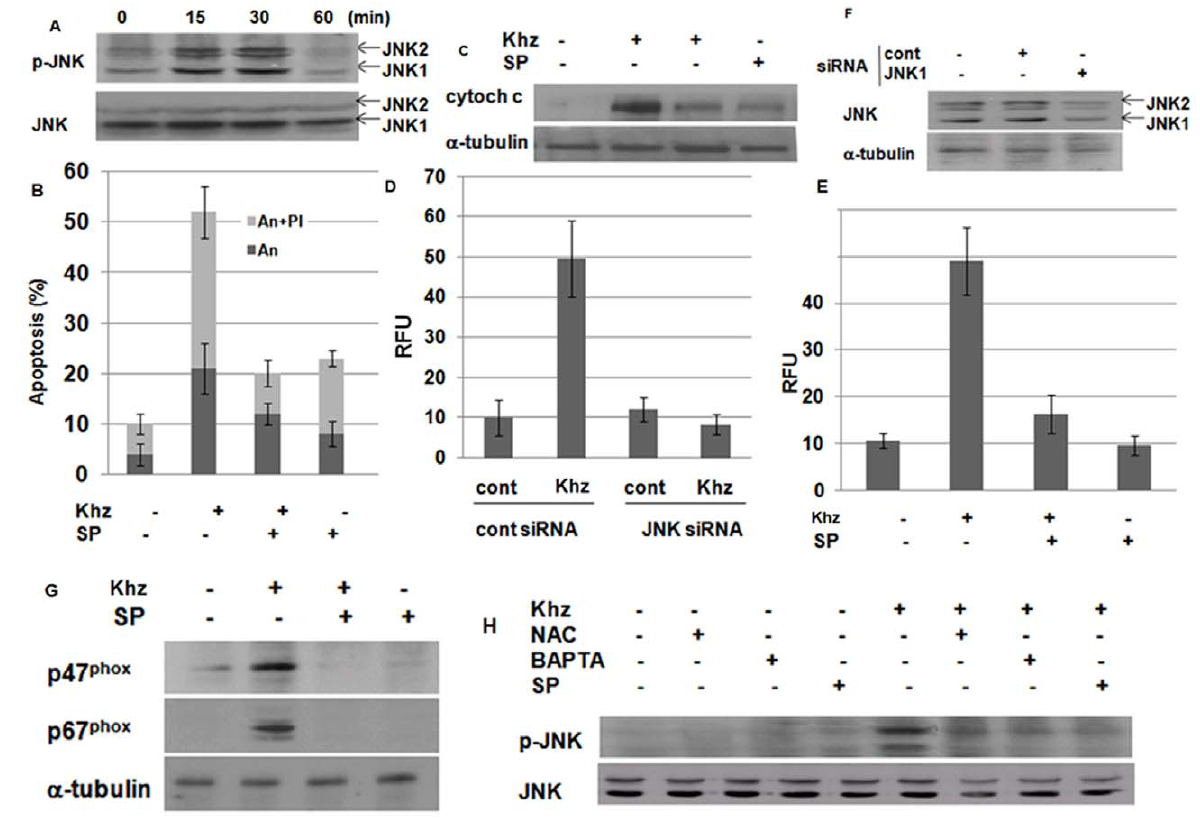
Figure 7. JNK mediates the increase in [Ca 2 + ] i to induce NADPH oxidase-derived ROS generation. (A) Activation of JNK was analyzed in Khz-treated HepG2 cells by immunoblot analysis of phosphorylated JNK. (B) Cells were pretreated with 20 m M SP600125 (SP) for 1 h. Apoptosis was analyzed 1 h after Khz treatment as in Fig. 2(C). (C) HepG2 cells were pretreated with JNK inhibitors as in (B), and cytochrome c levels in the cytosol were analyzed by immunoblotting 2 h after Khz treatment. (D, E) HepG2 cells were transfected with control or JNK-1 siRNA. After 48 h, ROS generation was analyzed 30 min after Khz treatment using the Amplex Red hydrogen peroxide assay. Data represent mean 6 SD (D). JNK protein expression was analyzed by immunoblotting 48 h after transfection (E). (F, G) HepG2 cells were pretreated with 20 m M SP200125 (SP) for 1 h, and ROS generation induced by Khz treatment was measured using the Amplex Red hydrogen peroxide assay. Data represent the mean 6 SD (F). Levels of p47 phox and p67 phox protein in the membrane fractions of HepG2 cells were analyzed by immunoblotting 15 min after Khz treatment (G). (H) HepG2 cells were pretreated with NAC (5 mM), BAPTA-AM (10 m M), and SP600125 (20 m M), and JNK phosphorylation was analyzed by immunoblotting 15 min after Khz